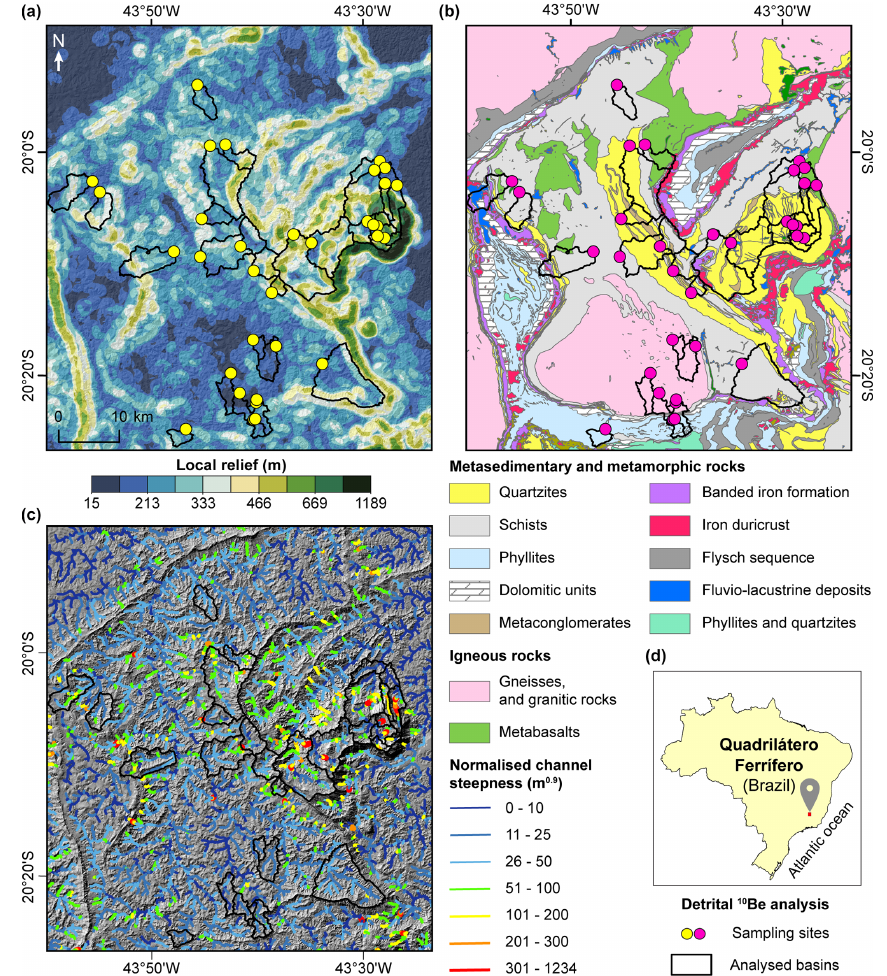
Figure 2. The geomorphic context of the Quadrilátero Ferrífero, Brazil. (a) Map of local topographic relief (extracted using a 2km diam- eter window). (b) Simplified bedrock geology in the study area, comprising mostly steeply dipping ( ≥ 35 ◦ ) Archean and Paleoproterozoic sequences. (c) Map of normalised channel steepness ( k sn ) extracted using the segmentation method of Mudd et al. (2014), with θ ref of 0.45. Note that we used an area threshold of 1.0km 2 to extract the drainage network, and we did not show sampling sites in (c) for illustration purposes. (d) The location of the QF in Brazil, ∼ 350km away (in a straight line) from the Atlantic